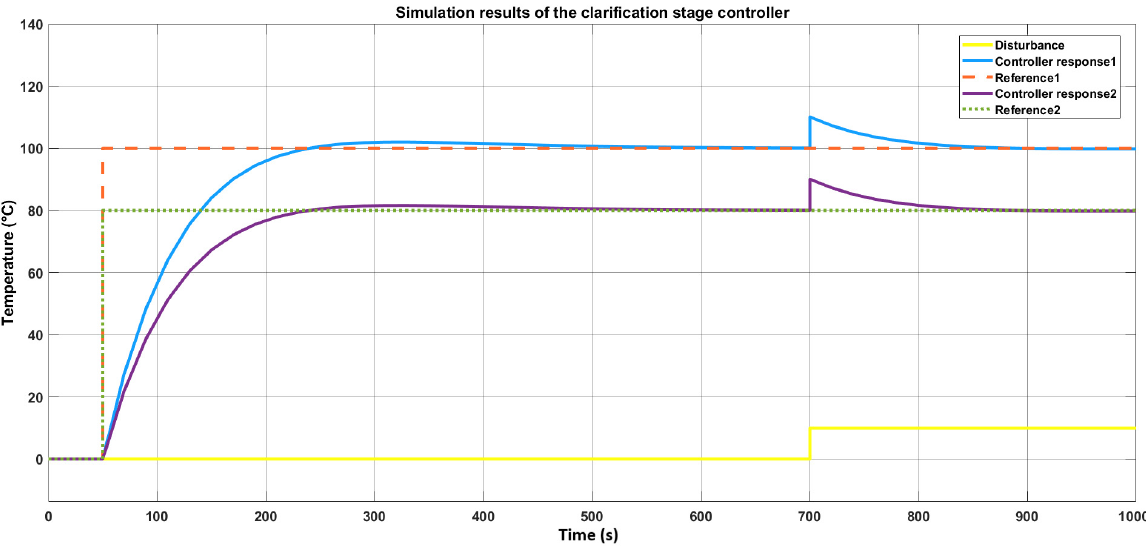
Figure 6. Simulation results of the clarification stage controller.